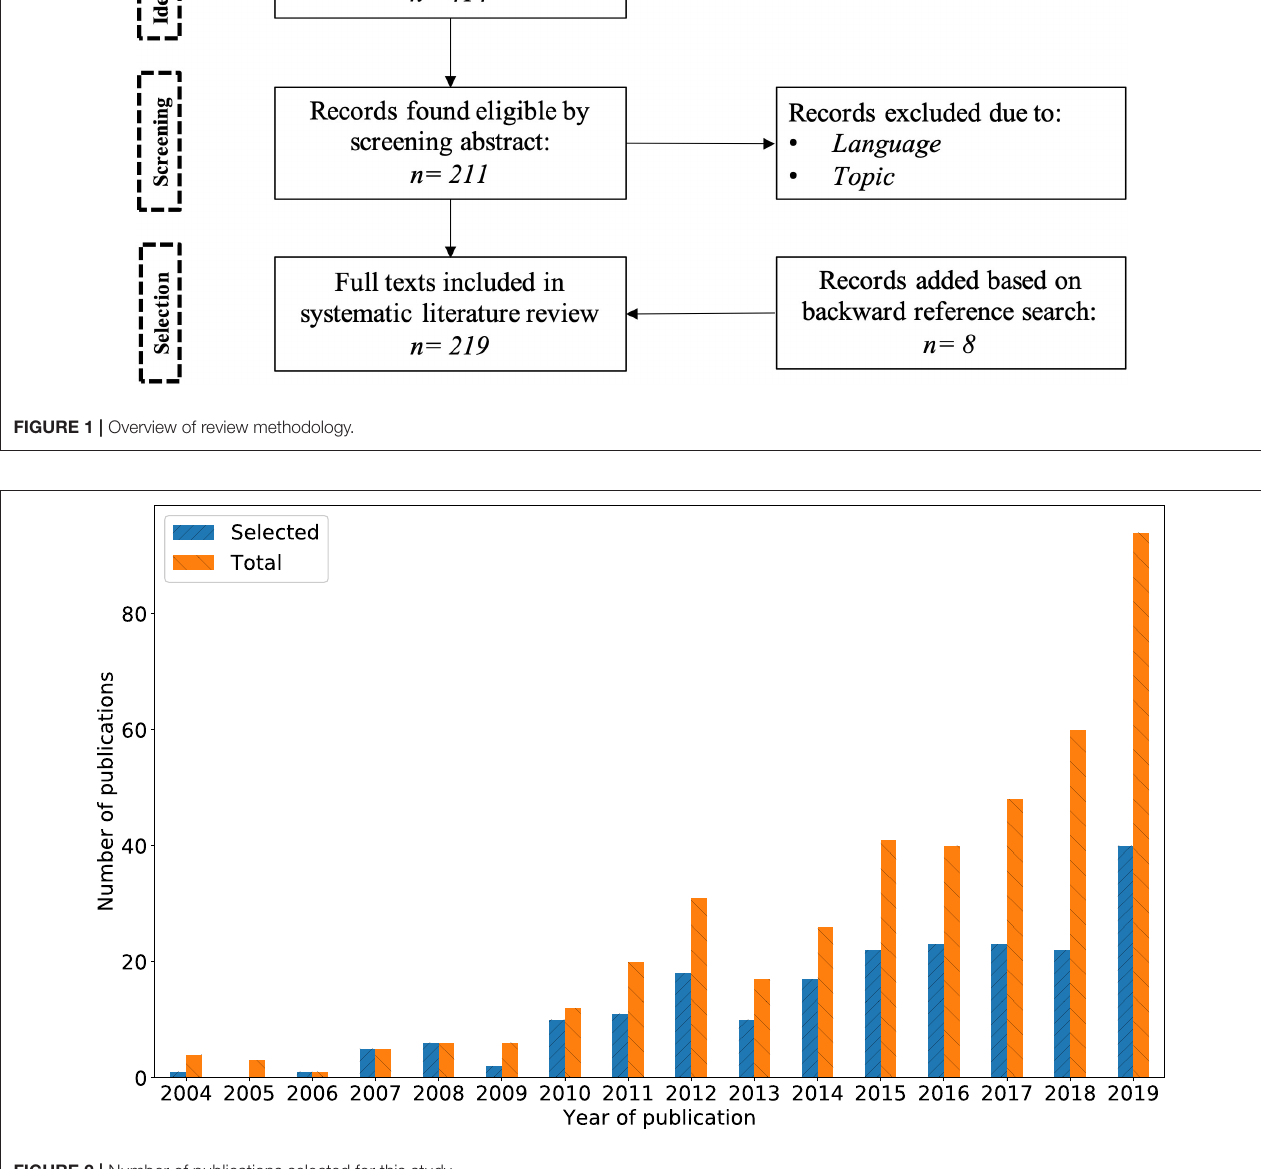
FIGURE 2 | Number of publications selected for this